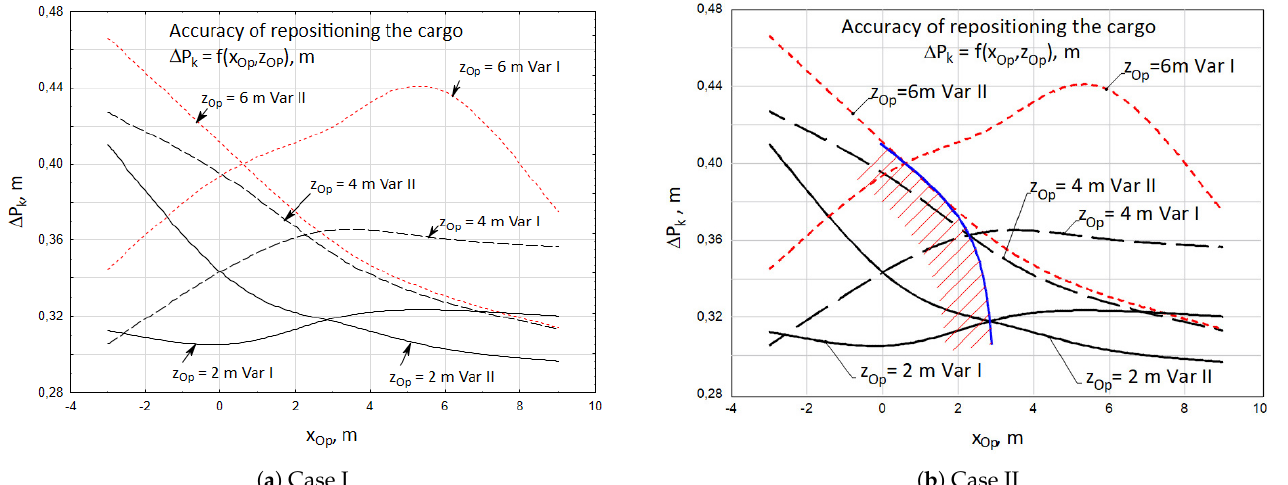
Figure 16. Accuracy of repositioning the cargo ∆ P k , for two cases of the realized cargo handling